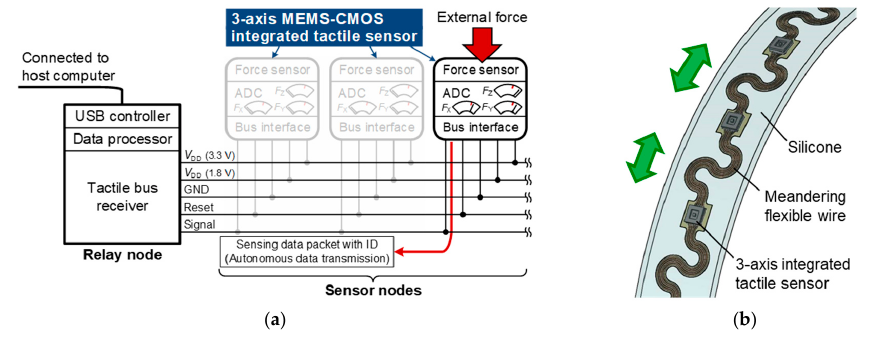
Figure 1. Conceptual figure of the 3-axis integrated tactile sensors on a flexible and stretchable bus line: ( a ) System diagram; ( b ) Physical implementation.